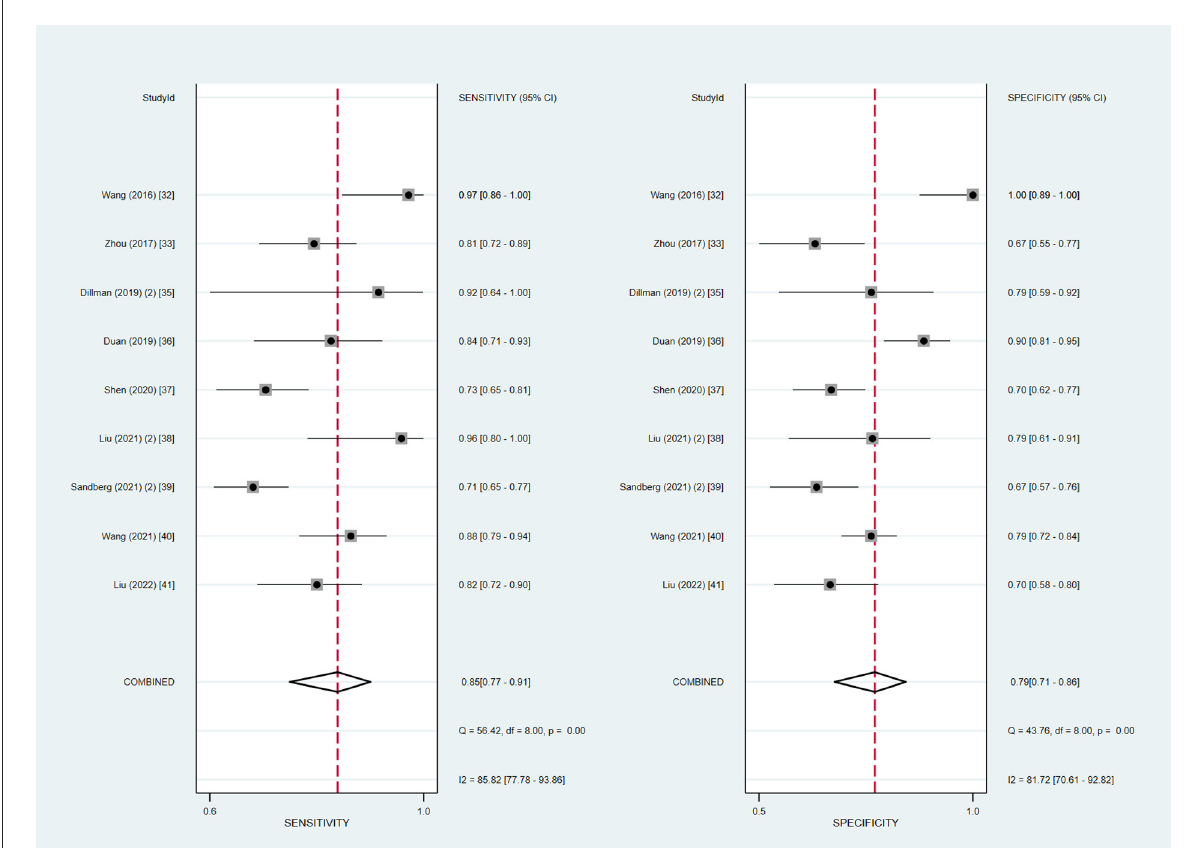
FIGURE5 Coupled forest plots of the summary sensitivity and specificity of the liver stiffness measurement in the two-dimensional shear wave elastography (2D-SWE)